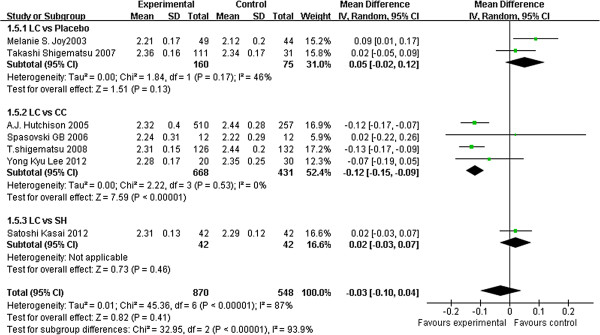
Forest plot of serum calcium in patients treated with LC and control therapy. Studies were identified by name of the first author and year of publication. Mean differences (MDs) were pooled using the random-effect model and shown on a scale of −0.2 to 0.2.